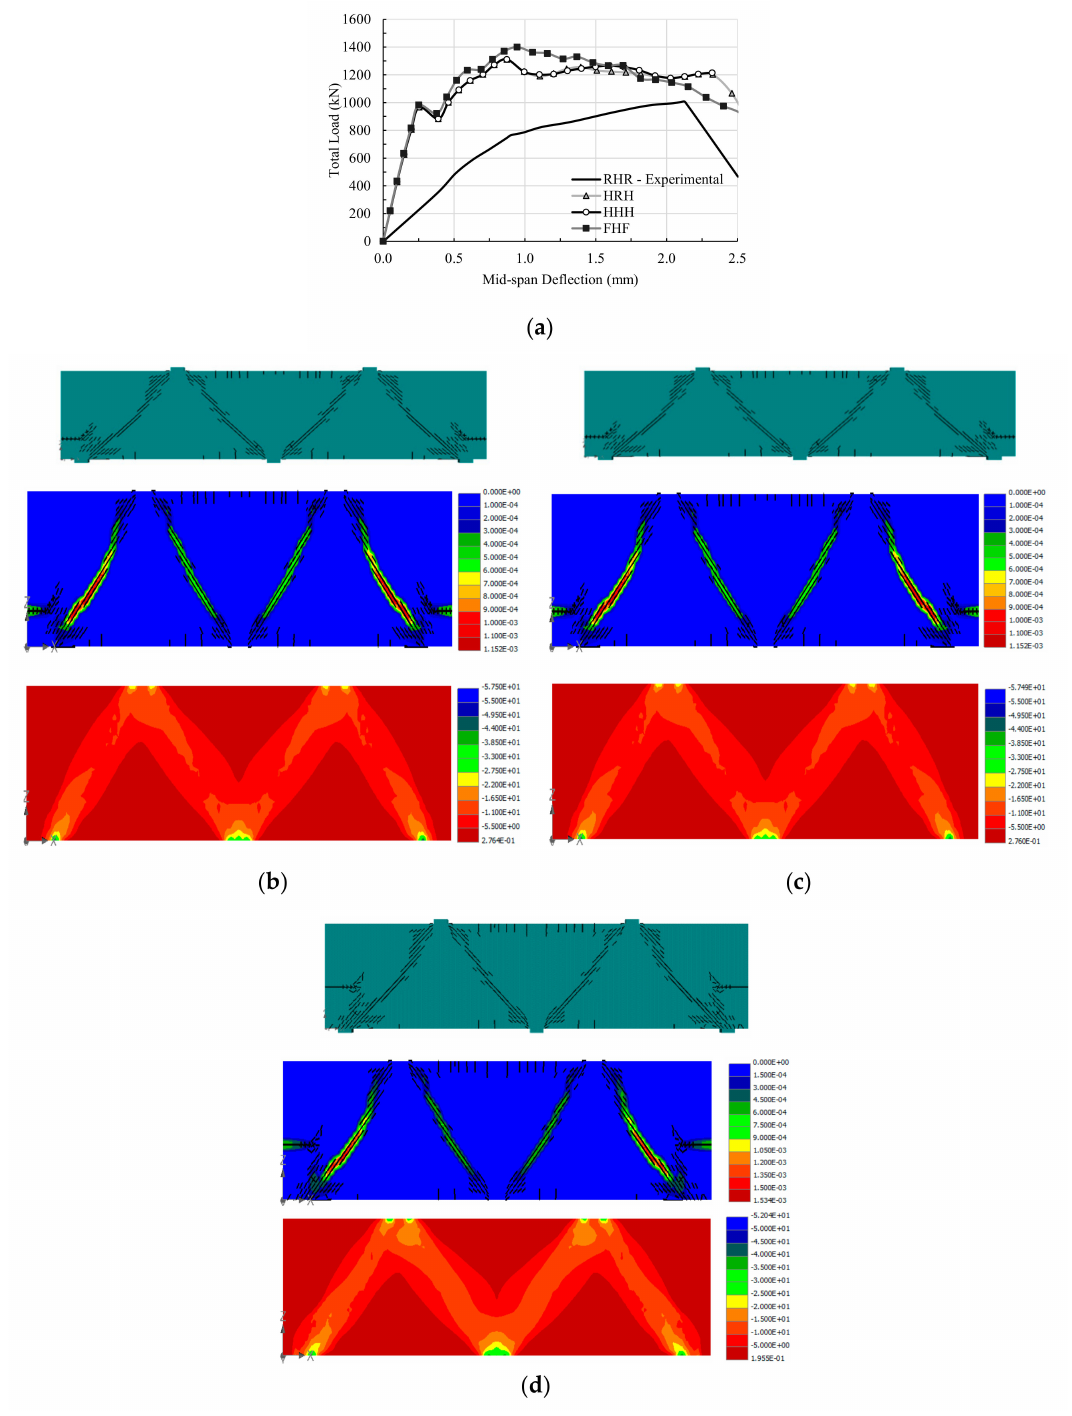
Figure 11. Responses of specimen L10-72 with three di ff erent sets of support conditions: ( a ) Experimental (RHR, [9]) and numerical Load-deflection curves for specimen L10-72; ( b ) crack pattern ( top ), crack width ( middle ), and stress distribution (MPa) ( bottom )—HRH support conditions; ( c ) crack pattern ( top ), crack width ( middle ), and stress distribution (MPa) ( bottom )—HHH support conditions; ( d ) crack pattern ( top ), crack width ( middle ), and stress distribution (MPa) ( bottom )—FHF support